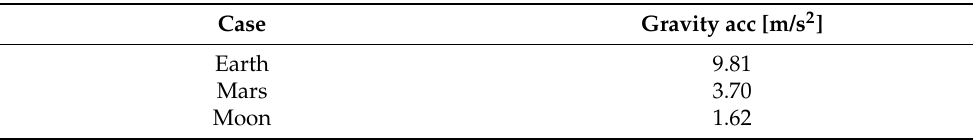
Table 1. Gravitational conditions used in DEM simulations.